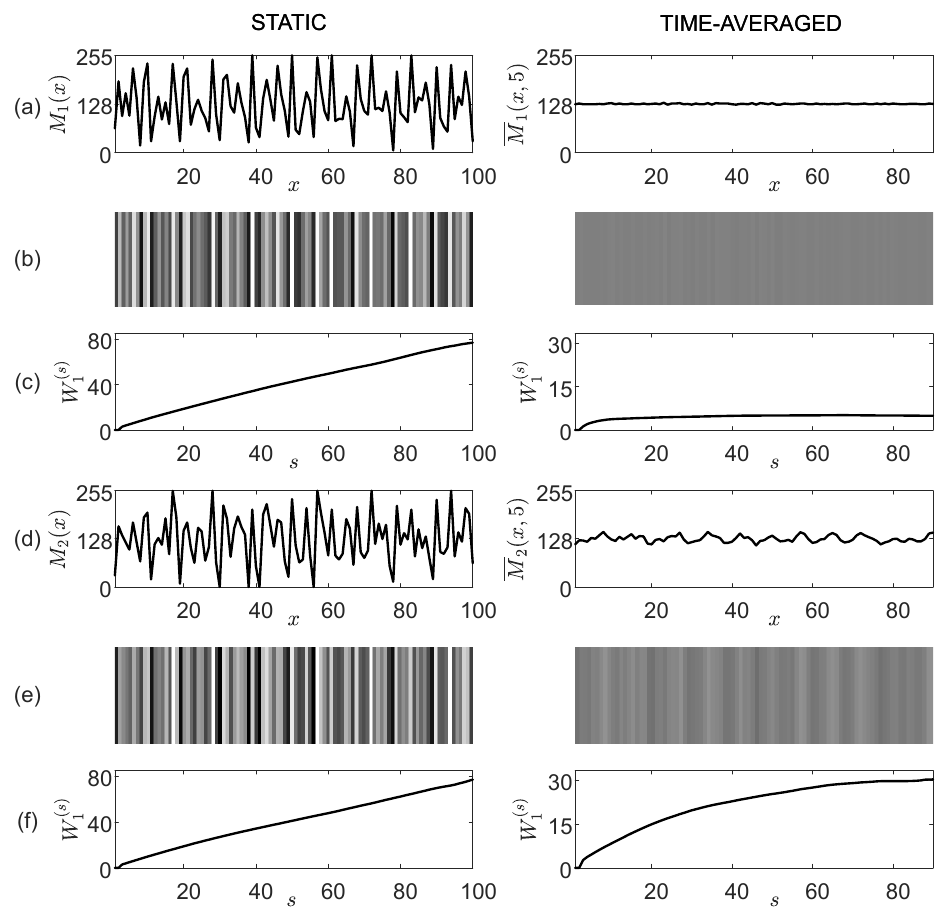
Figure 4. Stochastic gratings with similar statistical and visual characteristics yield different time- averaged gratings. The optimal grating M 1 ( x ) is depicted in panel ( a ); µ 1 = 127.8, σ 1 = 66.2. The statistical characteristics of the time-averaged grating M 1 ( x ,5 ) read as follows: µ The optical representations of M 1 ( x ) and M 1 ( x ,5 ) are depicted in panel ( b ). Wada indexes W M 1 ( x ) and M 1 ( x ,5 ) are shown in panel ( c ) ( ω shown in panel ( d ); µ 2 = 127.9, σ 2 = 66.2. The statistical characteristics of the time-averaged grating M 2 ( x ,5 ) read as follows: µ depicted in panel ( e ). Wada indexes W ( 2 ) = ω max